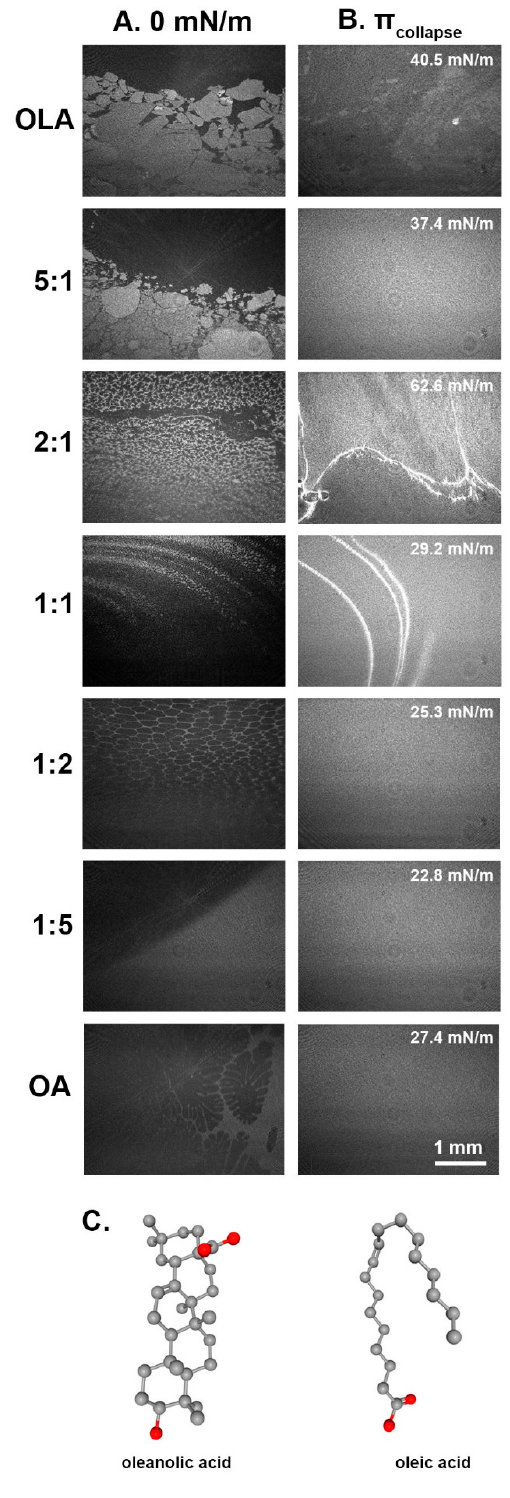
Figure 2. The BAM images of pure OLA and OA monolayers, as well as binary systems of OLA:OA for various mole fractions ( A ) at 0 mN/m just before compression start and ( B ) at π close to collapse, specific for a particular system. The mixed monolayers are of intermediate morphology between pure systems, but in the case of OLA:OA monolayer, there are some bright domains demonstrating phase separation. Importantly, a small content of OA to OLA monolayer (OLA:OA 5:1) resulted in a homogenous monolayer morphology. ( C ) Chemical structure depiction of oleanolic acid (left) and oleic acid